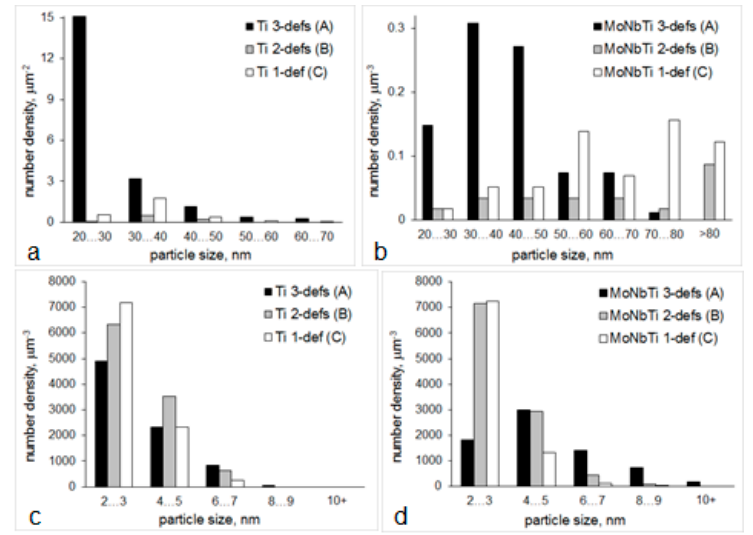
Figure 9. Variations in the ( a , b ) >20 nm and ( c , d ) <20 nm particle number density distributions with processing schedule for ( a , c ) Ti ‐ steel and ( b , d ) MoNbTi ‐ steel.